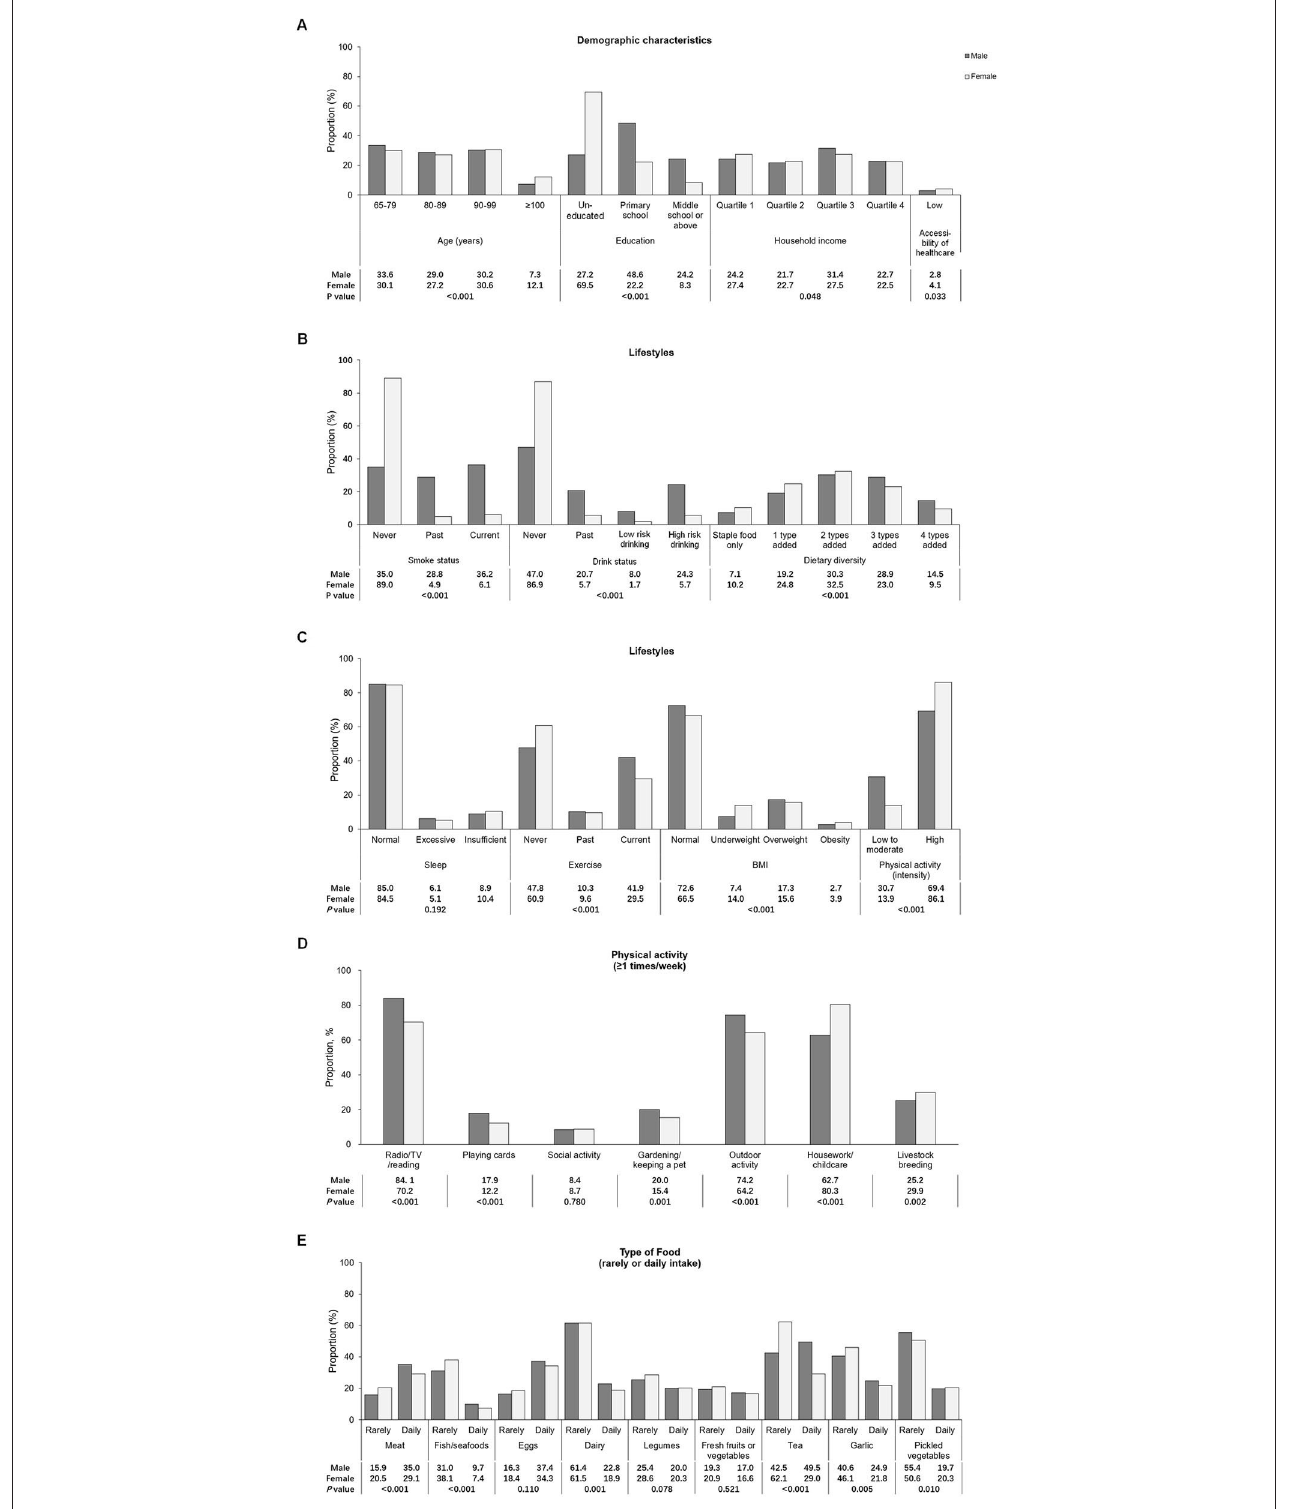
FIGURE 1 | Comparison of characteristics between genders. (A) The demographic characteristics and accessibility of healthcare. (B) Lifestyles, such as the status of smoke, drinking, and the diversity of diet. (C) Lifestyles, such as sleep conditions, habits of exercise, and daily physical activity categorized by intensity and the category of body mass index. (D) Type of daily physical activity. (E) Type of food intake. The comparison of types of food intake between genders was conducted using three groups of intake including rarely, sometimes and daily, of which the significance was presented in the current figure. The percentage of rarely and daily intake was presented using the bars whereas the percentage of food sometimes intake was not shown in this figure.